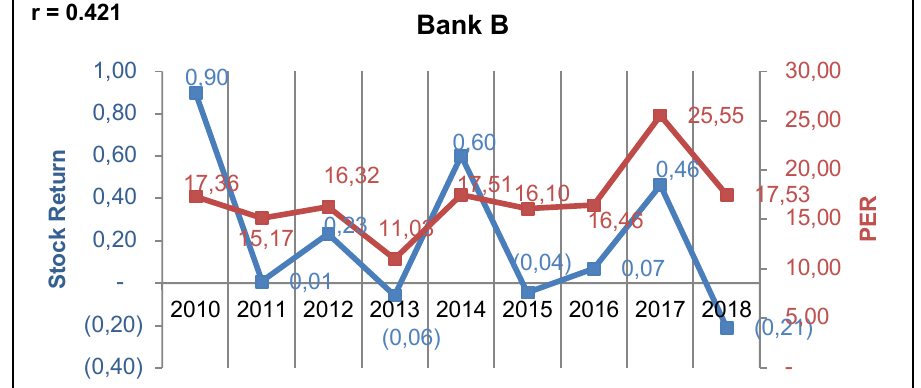
Figure 2: For Bank